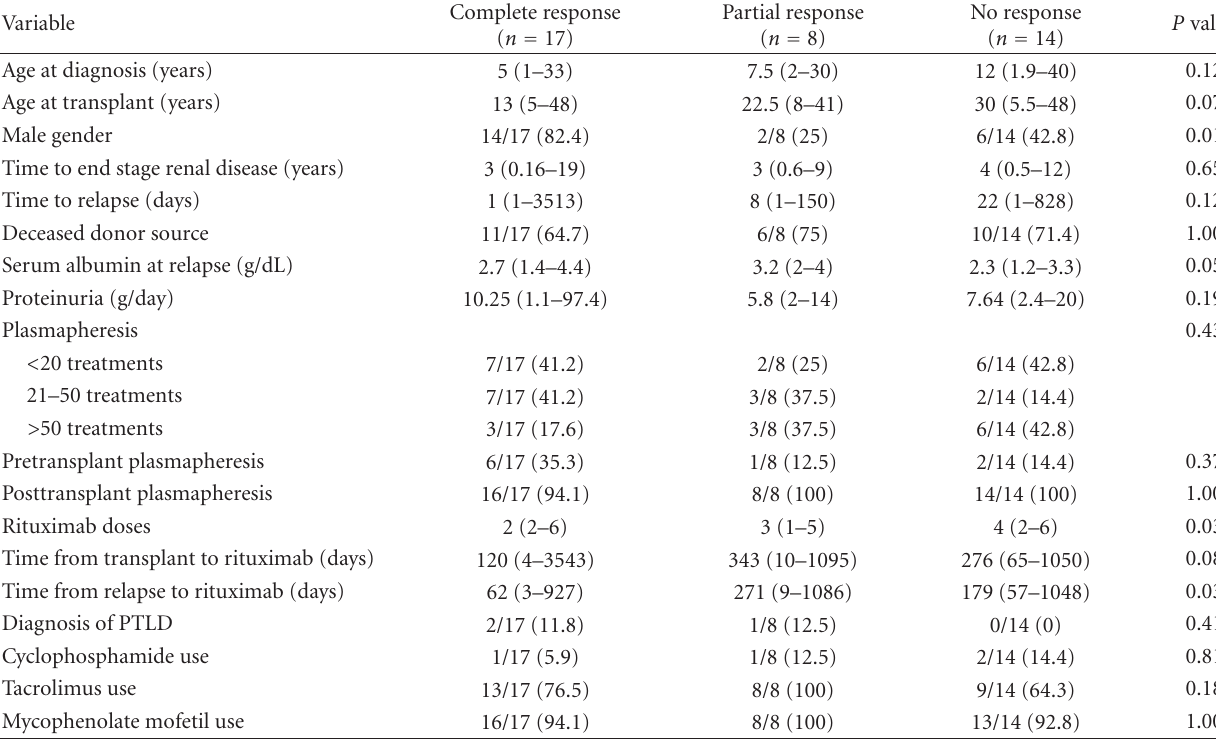
Table 3: Univariate analysis for the 3-outcome model of complete, partial response, and no response, to rituximab therapy. Values expressed as median (range) or proportion